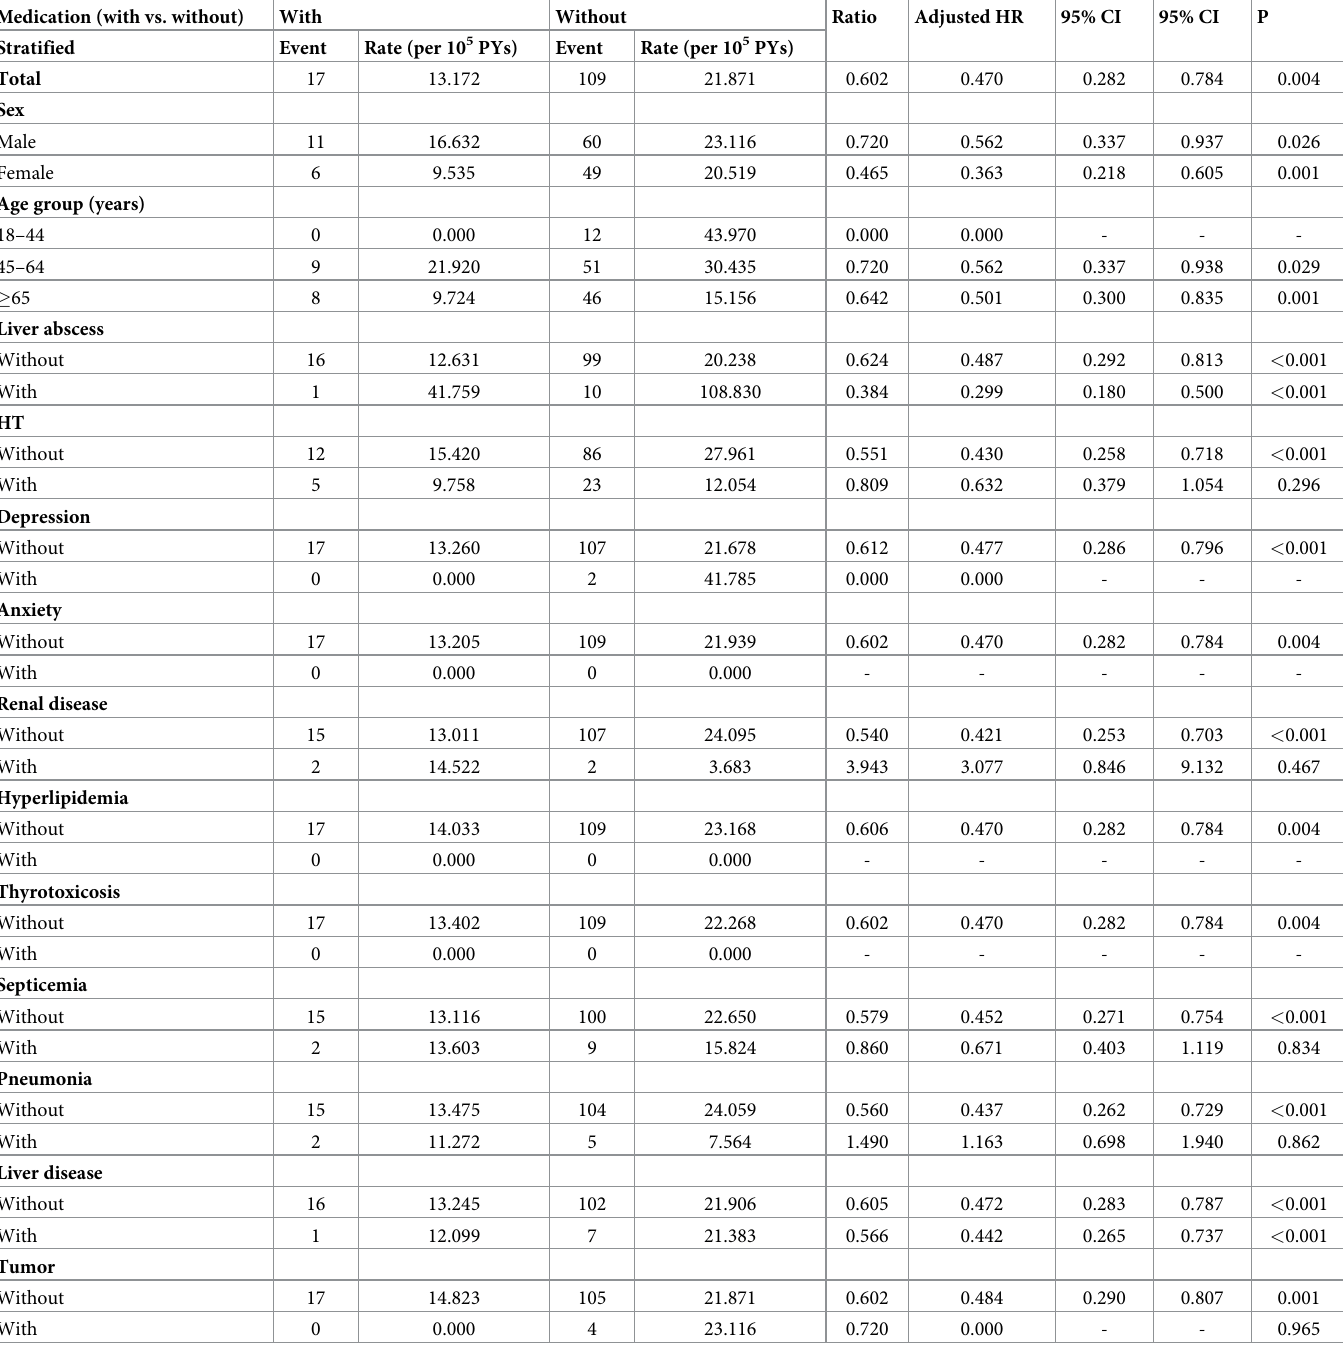
Table 2. Factors of endogenous endophthalmitis stratified by the variables listed in the table and evaluated using cox regression. Medication (with vs.